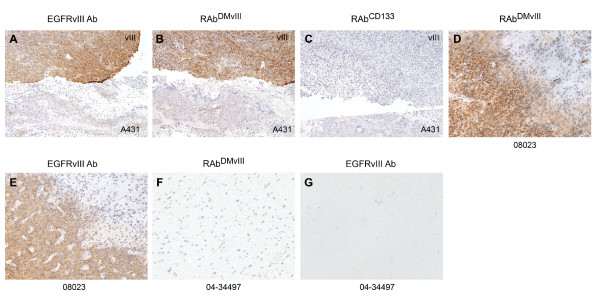
Detection of EGFRvIII by RAbDMvIII Immunohistochemistry. (A-C) Immunohistochemical staining of U87vIII & A431 mouse tumor xenografts and (D-G) Glioblastoma section. A) Staining of A431 and U87vIII with polyclonal EGFRvIII antibody. B) RAbDMvIII antibody staining, C) RAbCD133antibody staining. D) Glioblastoma 08-023 staining with RAbDMvIII. E) Glioblastoma 08-023 staining with polyclonal EGFRvIII ab. F) Glioblastoma 04-34497 stained with polyclonal EGFRvIII antibody and G) RAbDMvIII staining of 04-34497.